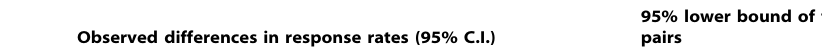
Table 2. Statistics achieved in the pilot study.